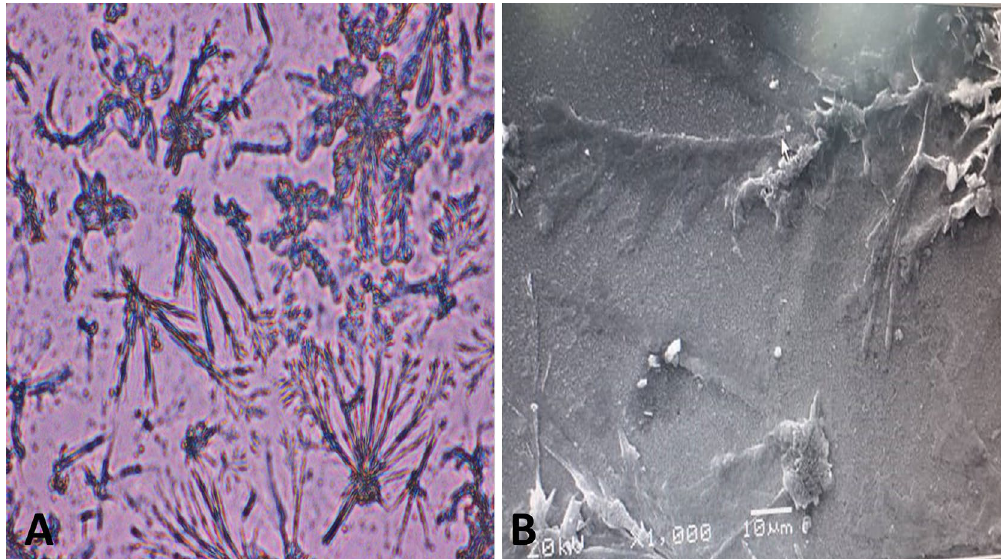
Figure 6. Attachment of Nile Tilapia fish scale-based collagen nanoparticles to theophylline showing the needle structure of theophylline as examined by light microscope (20X) ( A ) and scanning electron microscope (SEM) (5X) ( B ).